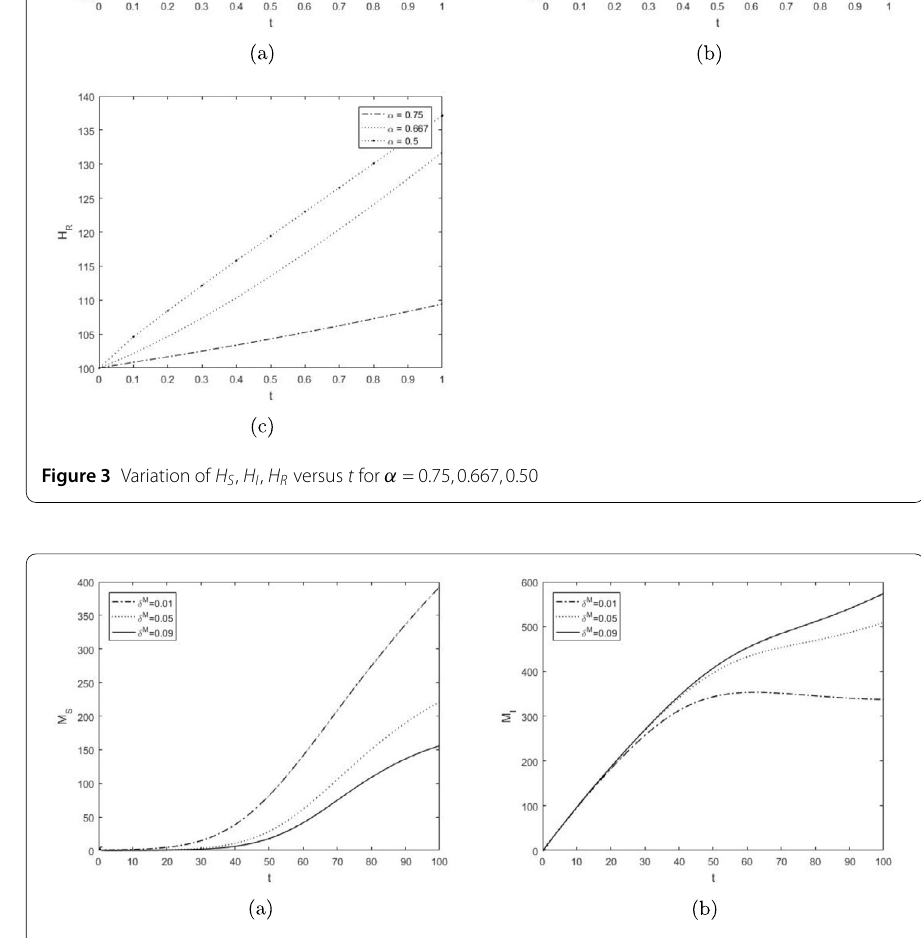
Figure 4 Variation of M S , M I versus t for δ M =